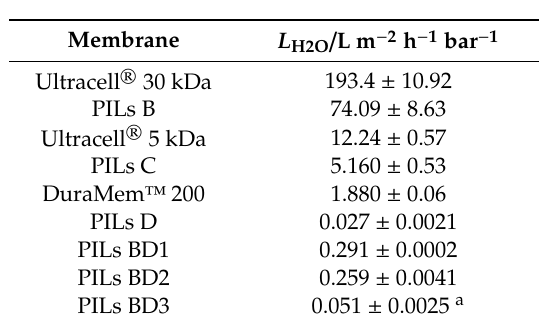
Table 1. Overview of permeance L H2O of di ff erent polymerized ionic liquid (PIL)-containing and commercial